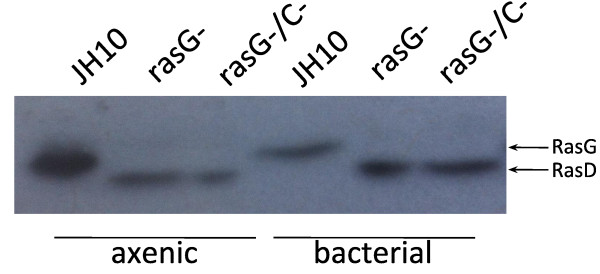
Total Ras expression in axenic and bacterially grown cells. Levels determined with Pan-Ras antibody. The lower Mr bands in the rasG- and rasG-rasC- lanes represents up-regulated RasD (arrow).